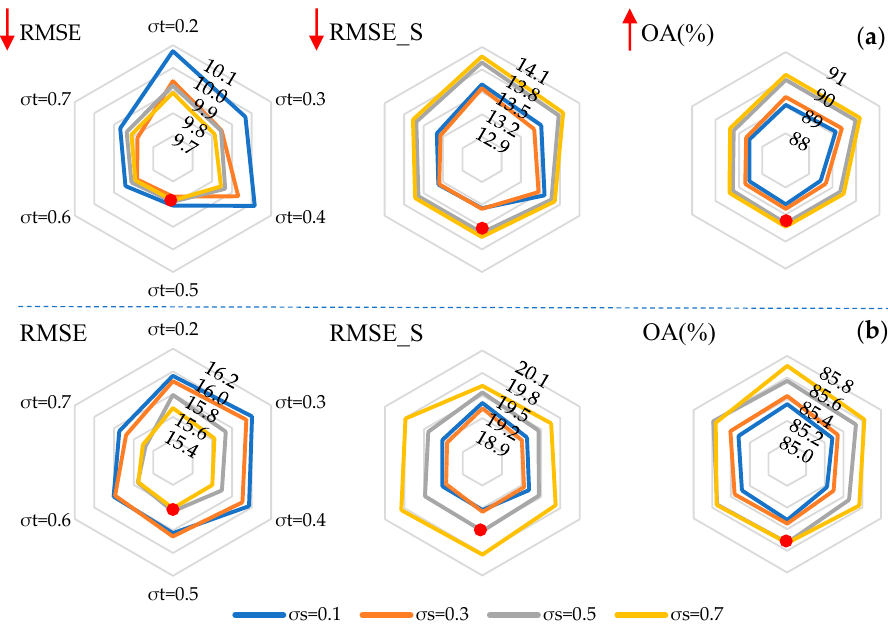
Figure 9. The parameter testing of σ s and σ t . ( a ) The results for “A1”. ( b ) The results for “A2”.